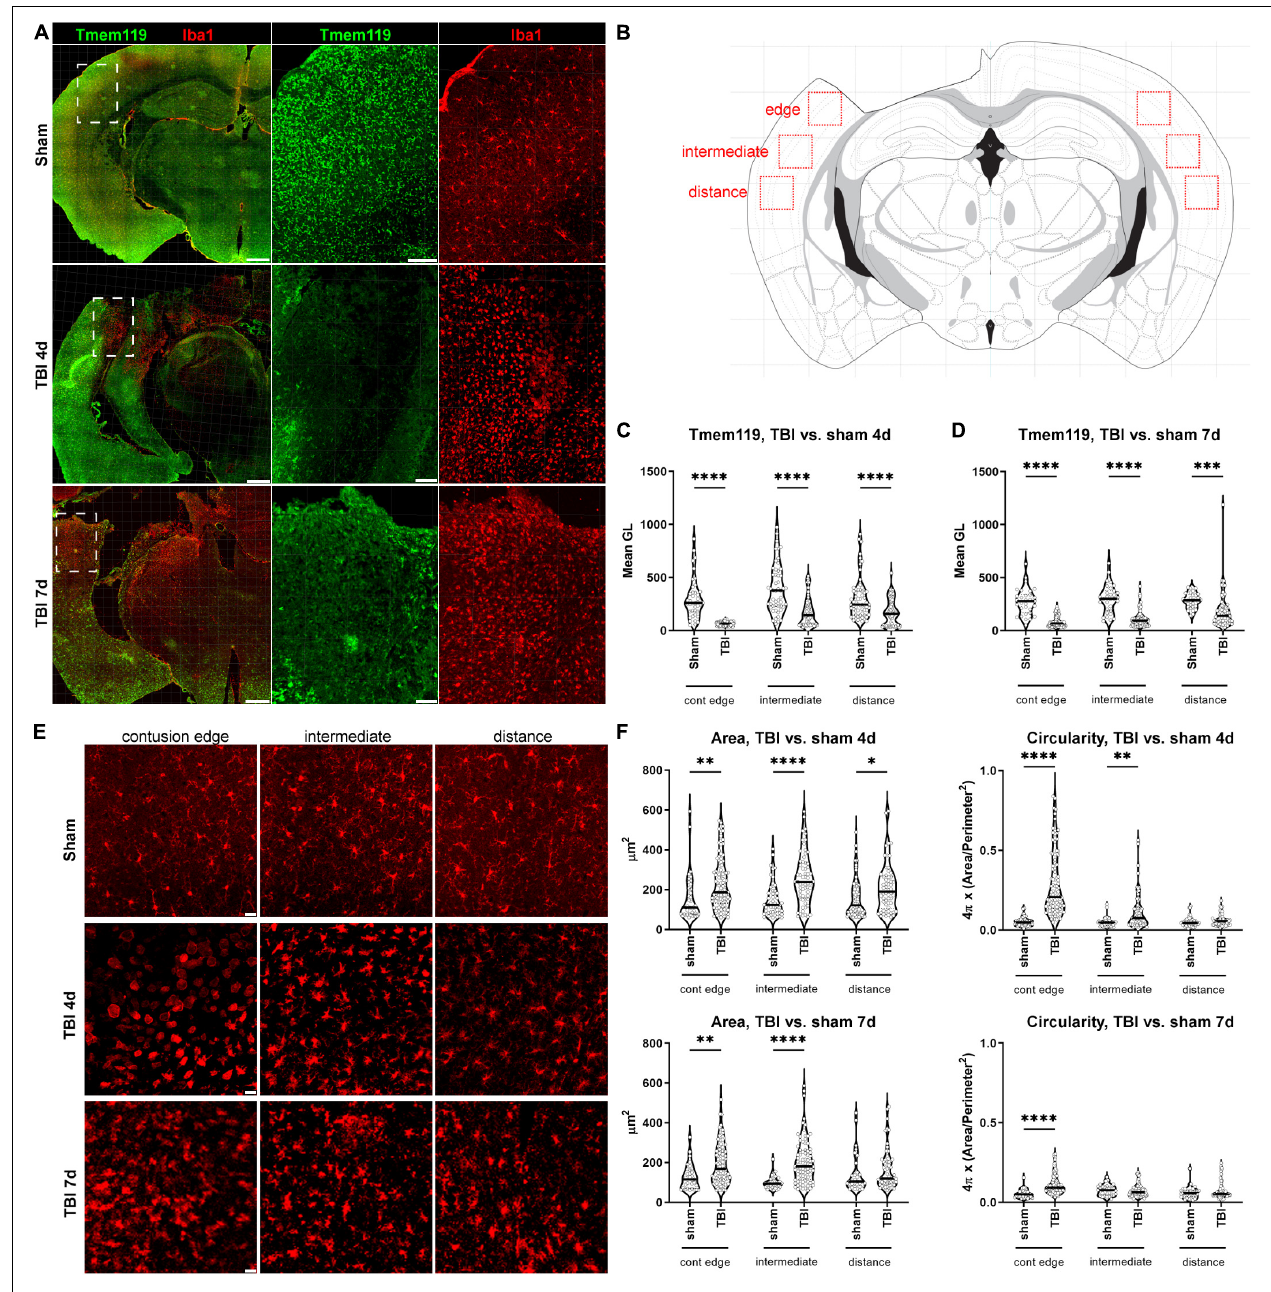
FIGURE 3 | Tmem119 immunoreactivity in cortical areas with activated Iba1+ cells after TBI. (A) Representative large image showing Tmem119 + (green) and Iba1 + (red) cells in sham-operated and TBI mice at 4 or 7 days after injury. The Tmem119 immunoreactivity decreased after TBI and this was associated with a morphological change of myeloid cells indicative of their activation. Scale bars 500 µ m in the large image, 100 µ m in the magnified inserts. Inserts corresponding to white dashed boxes. (B) Anatomical location of the three different regions of interest (red boxes) used for subsequent Tmem119 and Iba1 quantifications. We acquired at the contusion edge and at regions located at 350 µ m (intermediate) and 700 µ m (distance) from it. Drawing of the section modified from the Parkinson’s atlas of the mouse brain. (C,D) Tmem119 levels in sham and TBI mice at 4 (C) and 7 (D) days after injury. Tmem119 immunoreactivity decreased after injury in all the areas of interest analyzed. Data are shown as violin plot with single replicates (cells), a line at median and quartiles, and n = 92–155 cells from three mice per group. Two-way ANOVA followed by Sidak’s multiple comparison test, ∗∗∗ p < 0.01, ∗∗∗∗ p < 0.0001. (E) Representative micro photograms showing Iba1+ cells at the three different areas of interests in sham and TBI mice at 4 and 7 days after injury. Iba1+ cells acquired an ameboid morphology when close to the contusion edge at both time points. Scale bars 20 µ m. (F) The quantification of morphological parameters showed that Iba1+ cells had increased area and circularity, in particular, in the region near the contusion at 4 days. Data are shown as violin plot with single replicates (cells), line at median and quartiles, n = 92–155 cells from three mice per group. Two-way ANOVA followed by Sidak’s multiple comparison test, ∗∗∗∗ p < 0.0001, ∗∗ p < 0.01, and ∗ p < 0.05.